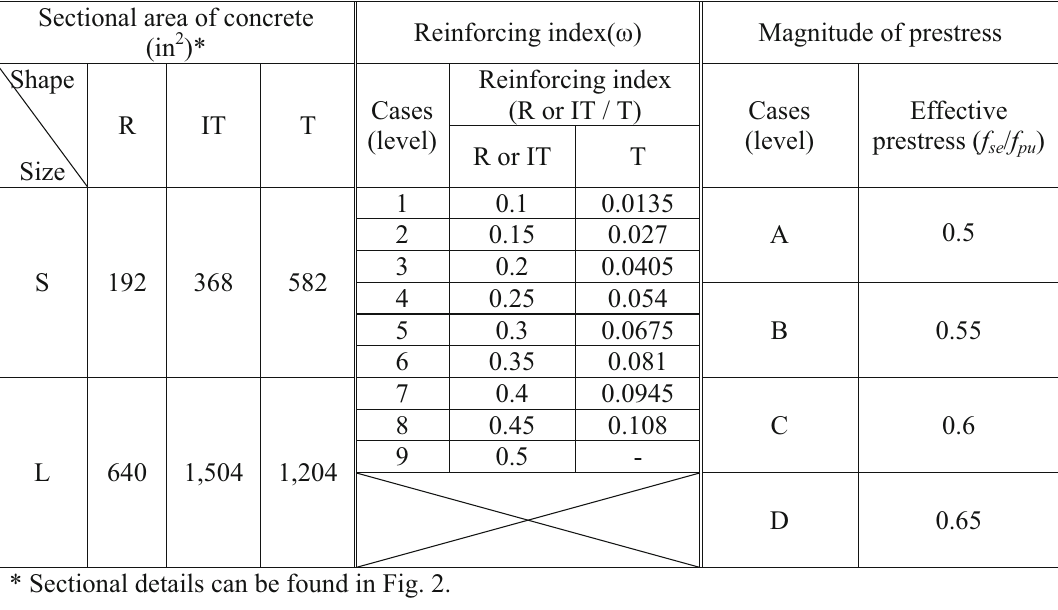
* Sectional details can be found in Fig.